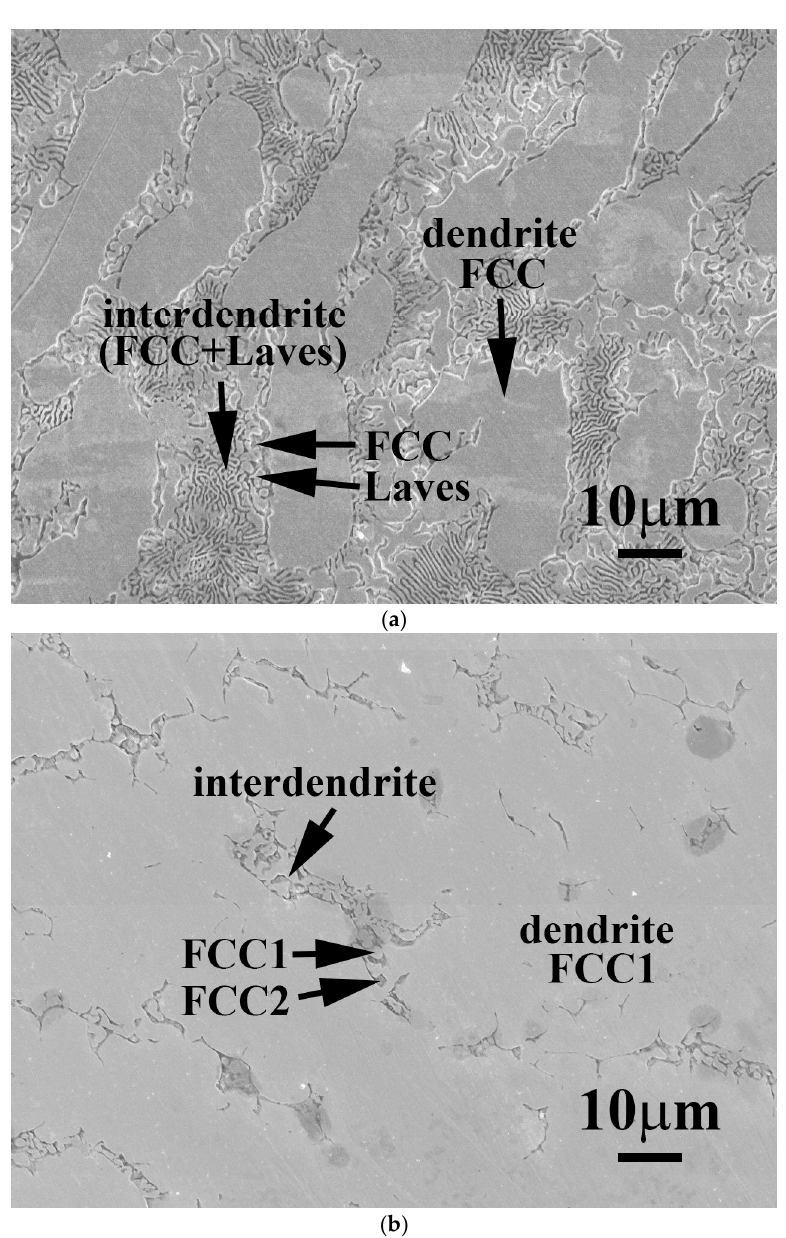
Figure 1. The microstructures of ( a ) FeCoNiNb 0.5 Mo 0.5 alloy; and ( b ) FeCoNiNb alloy.